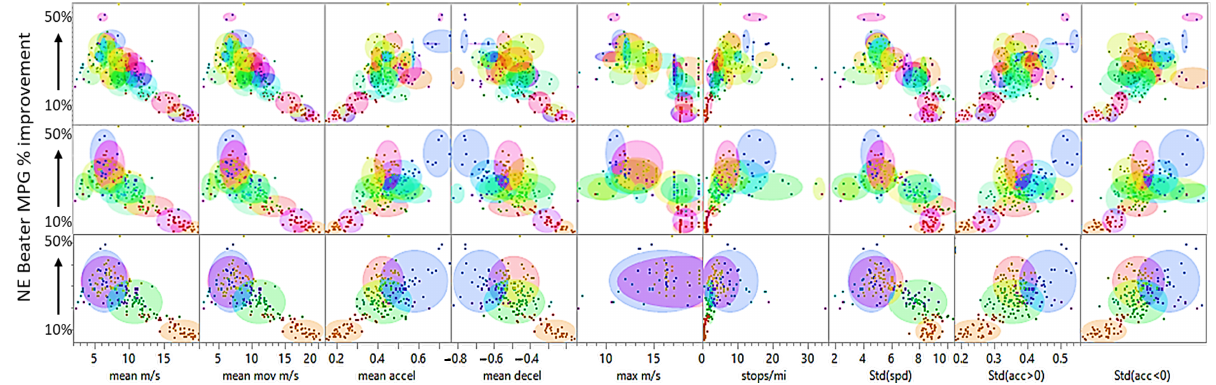
Figure 9. Three sets of K-means clusters, 44 clusters ( top ), 14 clusters ( middle ) and 5 clusters ( bottom ). Each set was generated from the training drive cycle characteristics and their associated NE Beater controller performance.